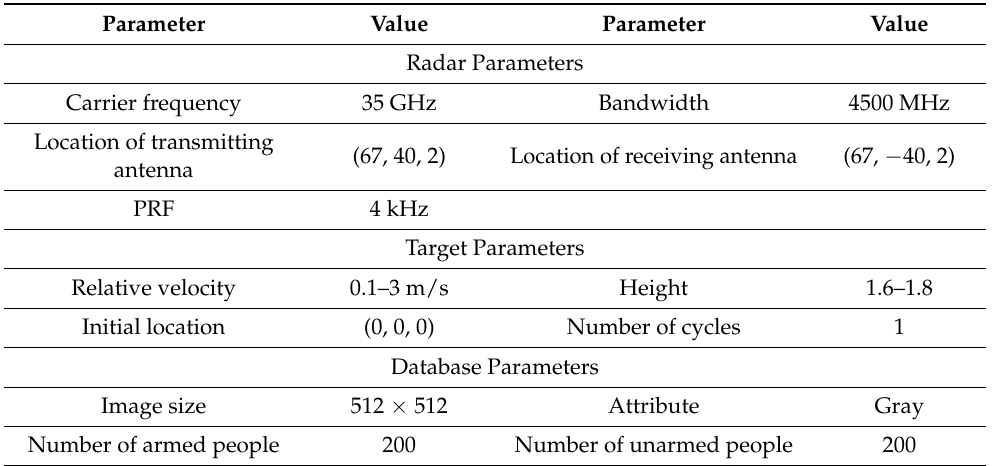
Table 1. Armed and unarmed pedestrian walking database construction